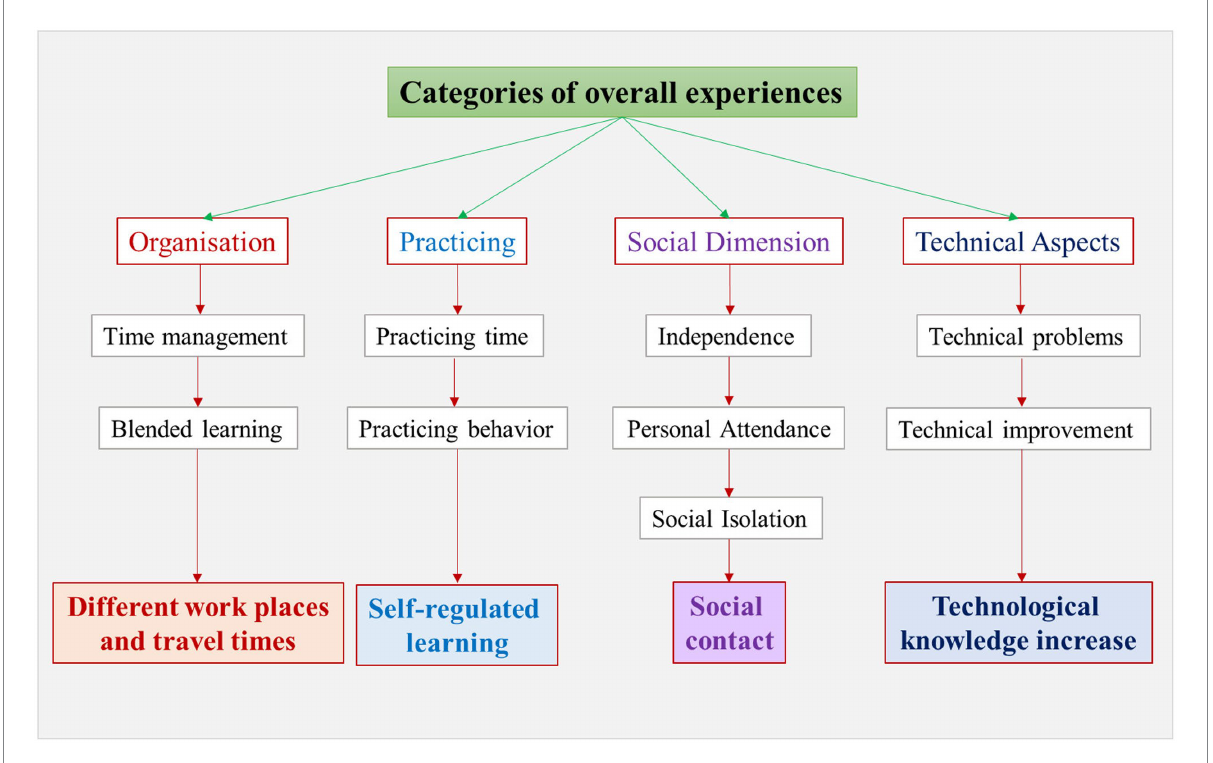
FIGURE 2 Inductive category system based on the open text responses of the